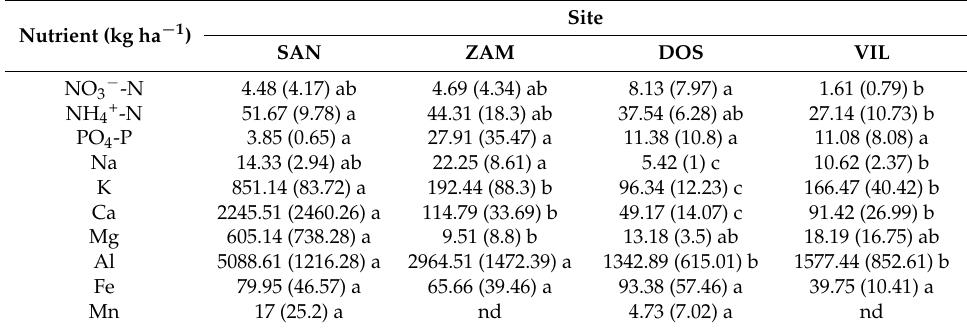
Medians and median absolute deviations MAD in parenthesis. Within each row, different letters indicate significant differences (Benjamini and Hochberg pairwise procedure (HB) after Kruskal-Wallis test, p < 0.05). nDOS = 6; nSAN = 3; nVIL = 7; nZAM = 7. nd: not